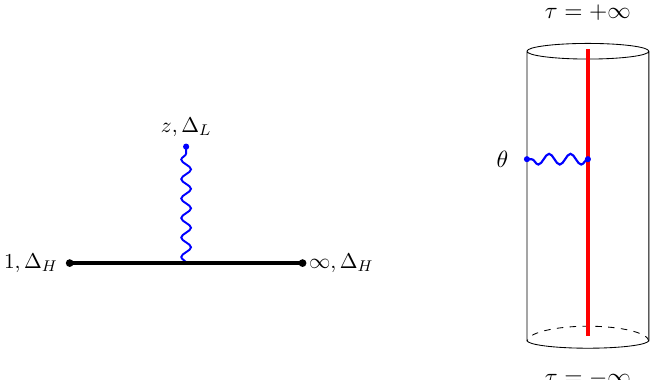
Figure 2 . The 3-point HHL block and its holographically dual realization in the three dimensional bulk (a rigid cylinder). The red line along the cylinder axis visualizes the 2-point function of heavy operators inserted at in(cid:12)nities that produced the conical defect. The wavy blue line denotes the perturbative operator propagating in the O L